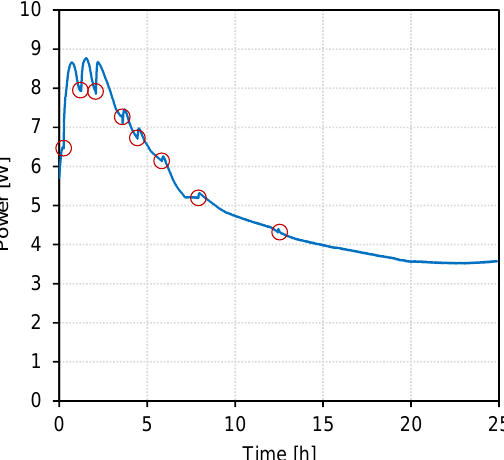
Figure 4. Power over treatment time for the batch EDBM treatment of BL model solution, U cell = 10 V (constant). The red circles mark the points of NaOH addition.